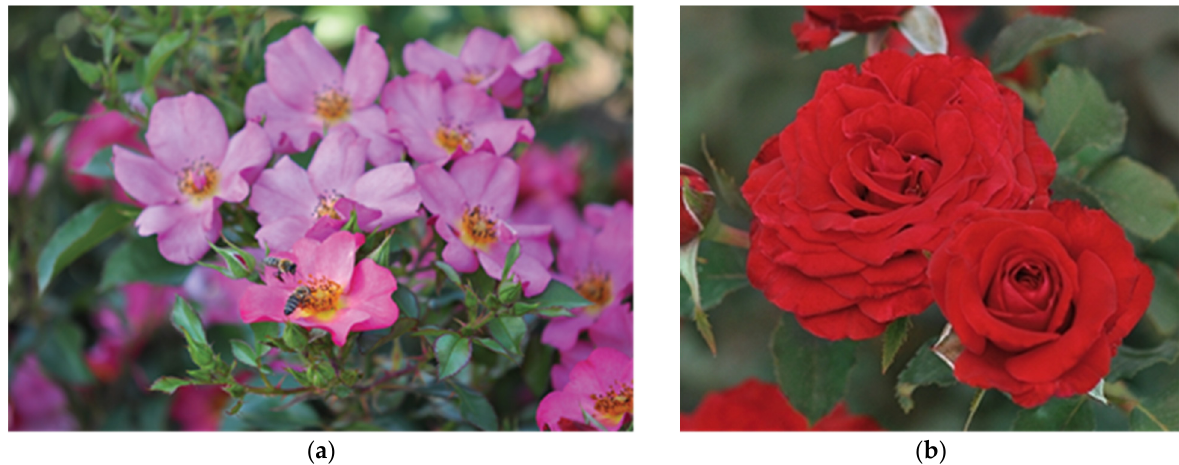
Figure 3. Flower morphology of ‘Barbie Mella’ ( a ) and ‘Carmine Vase’ ( b ) roses. Table 7. Wild bees recorded foraging on the ‘Mella’